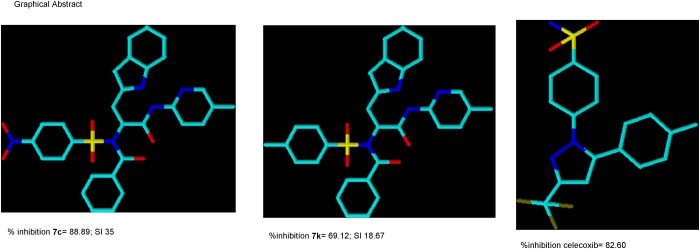
Graphical abstract.